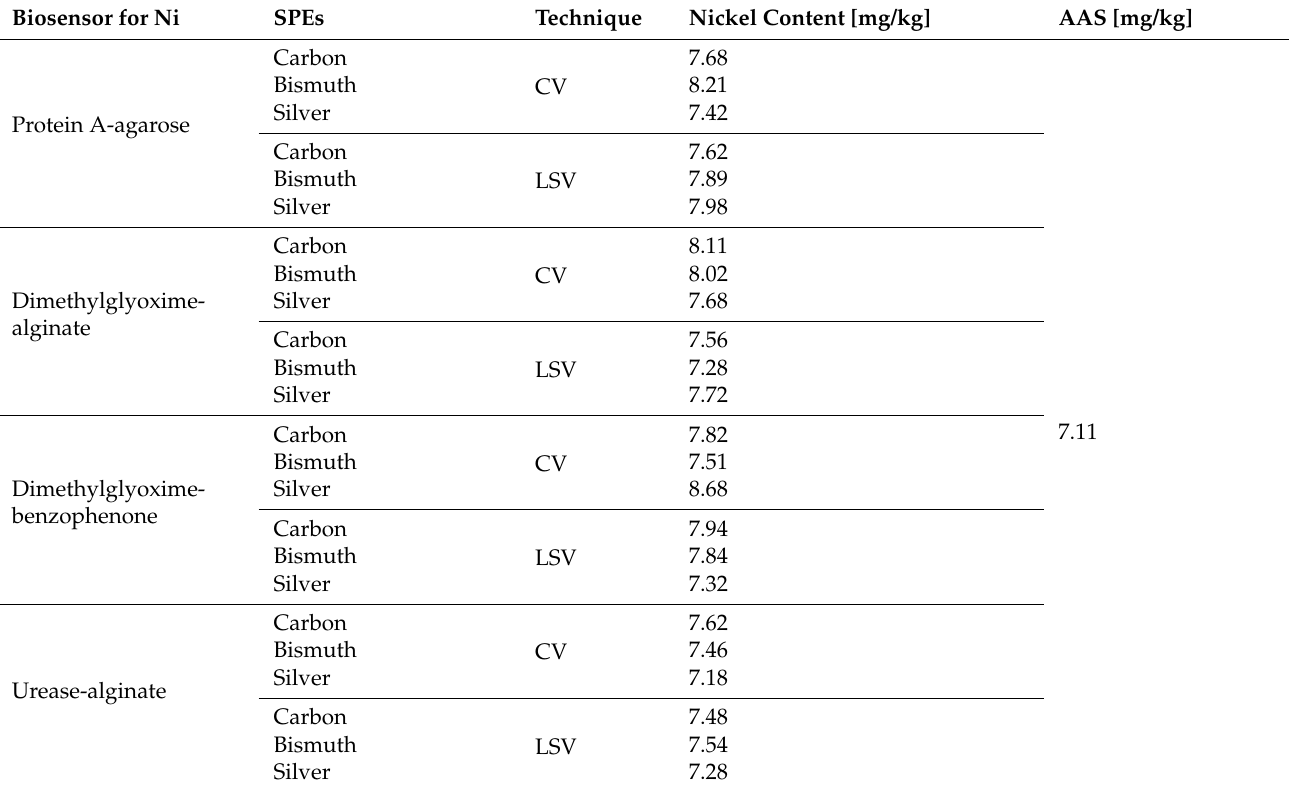
Table 4. Nickel content in red radish ( Raphanus sativus